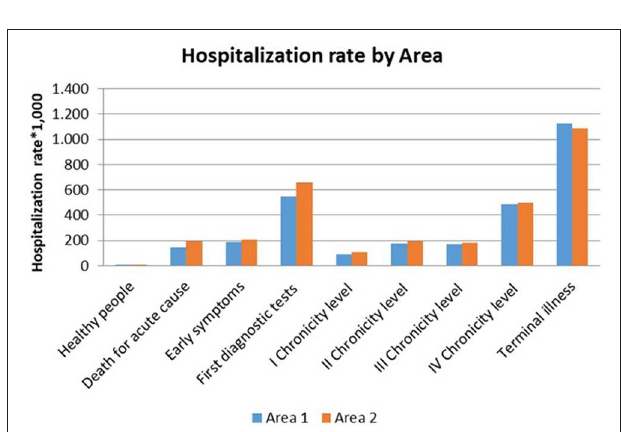
FIGURE 5 | Hospitalization rate per 1.000 (ordinary